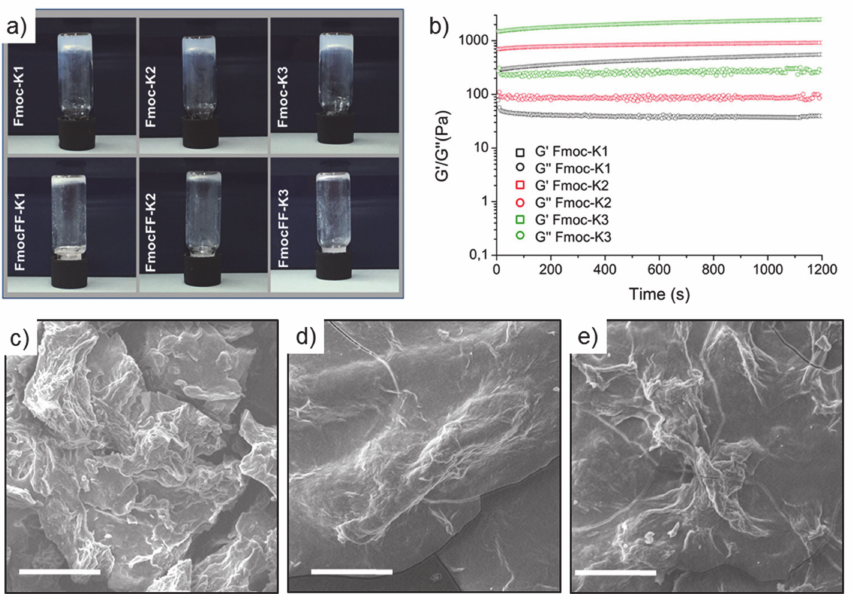
Figure 5. Three-dimensional (3D) hydrogel characterization. ( a ) Inverted test tubes of peptides at a concentration of 2.0 wt% in 14 mM phosphate buffer solution. ( b ) hydrogel rheological analysis: time sweep rheological analysis of Fmoc-K hydrogels reported as storage modulus (G (cid:48) ) and loss modulus (G”). SEM micro-photos of Fmoc-K1 ( c ), Fmoc-K2 ( d ), and Fmoc-K3 ( e ). Scale bars are 30 µ m, 2700 ×